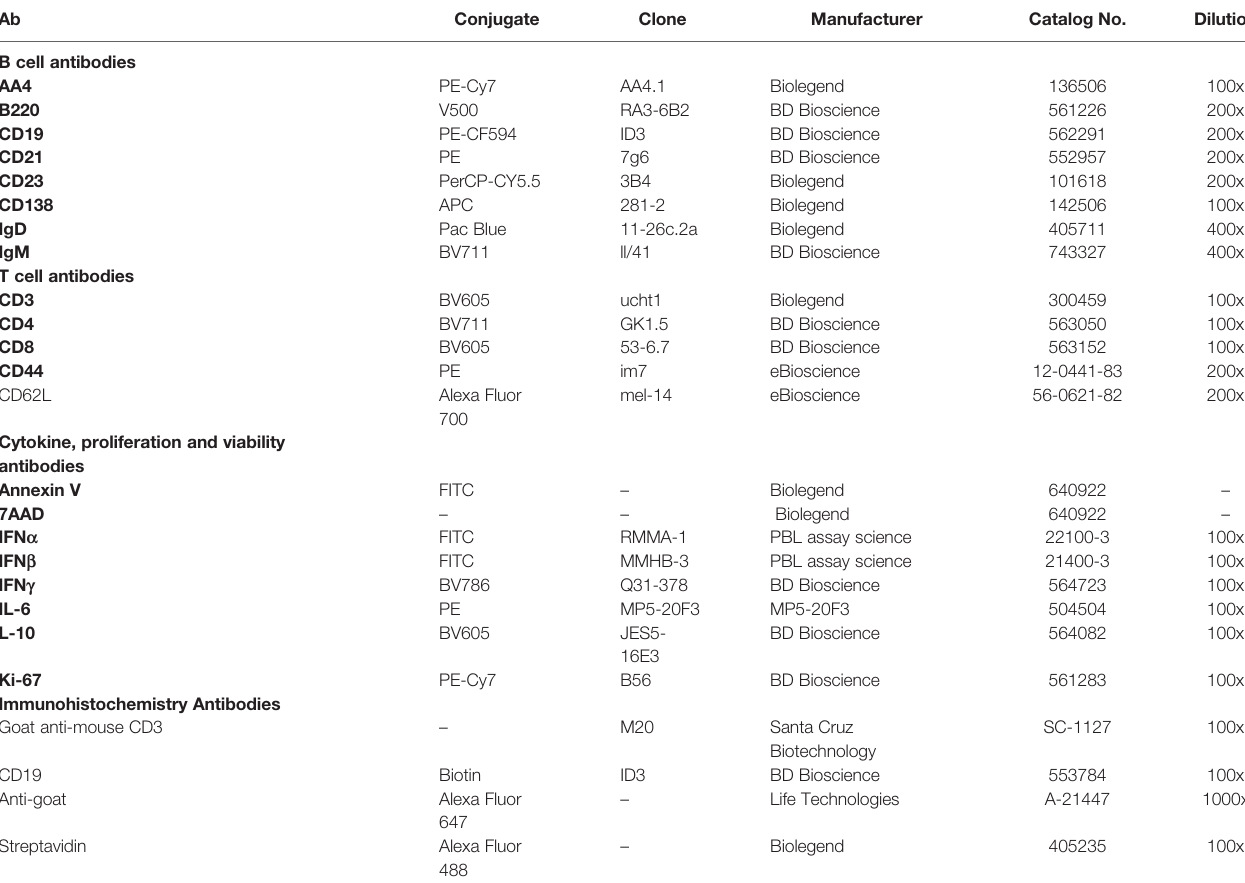
TABLE 1 | Antibodies used in this study. Ab